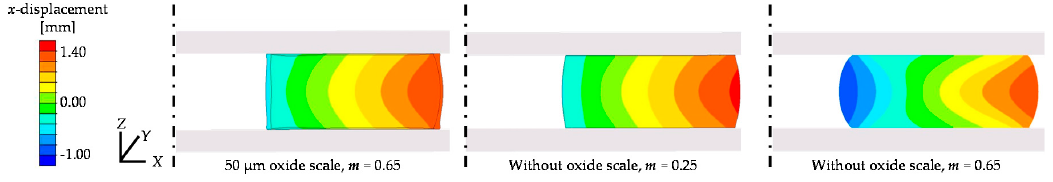
Figure 10. Final component shape and x -displacement depending on the friction factor m and the oxide scale.